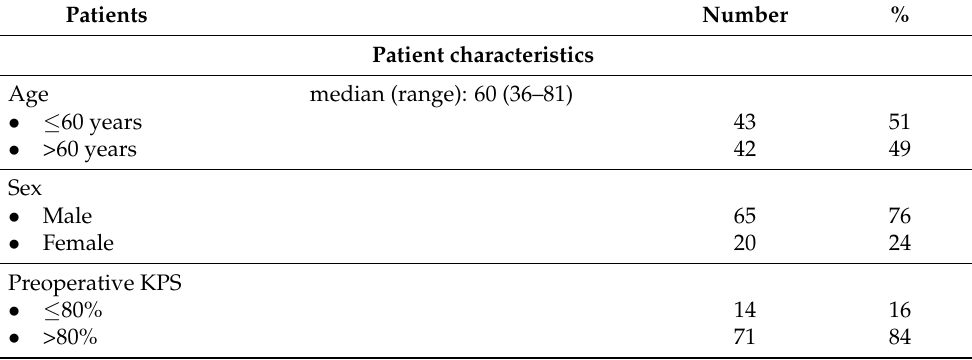
Table 1. Characteristics of the patients with primary IDH-wildtype GB treated with the standard therapy. Abbreviations: dNLR, derived neutrophil-to-lymphocyte ratio; GTR, gross total resection (100%); KPS, Karnofsky performance score; LMR, lymphocyte-to-monocyte ratio; NLR, neutrophil-to- lymphocyte ratio; OS, overall survival; PFS, progression-free survival; PLR, platelet-to-lymphocyte ratio; PR, partial resection (<90%); RBC, red blood cells; SII, systemic immune-inflammation index; SIRI, systemic inflammation response index; STR, subtotal resection ( ≥ 90%); TMZ, temozolomide; WBC, white blood